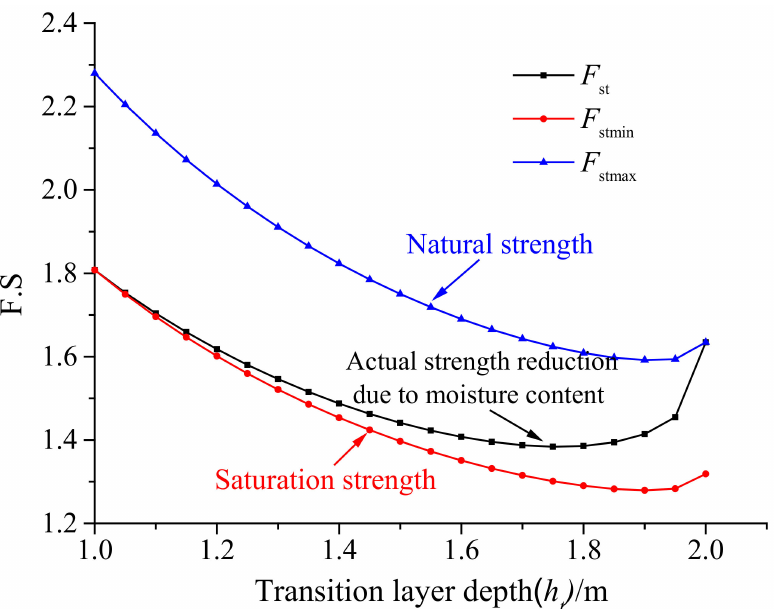
Figure 7. Safety factor in the transition layer versus the depth of transition layer ( h s = 1 m and h f = 2